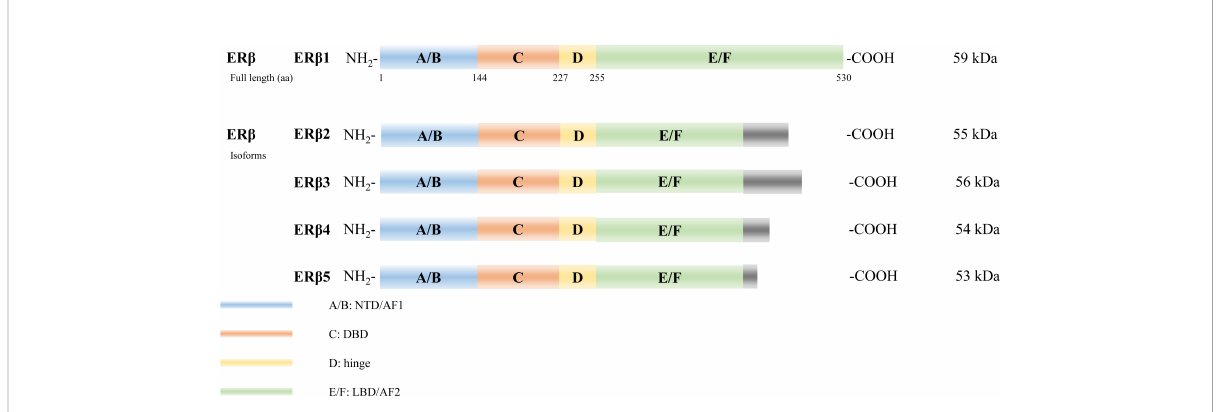
FIGURE 3 Estrogen receptor beta (ER b ) isoforms. Six structural and functional domains are highlighted: A, B domain (amino- or NH 2 -terminal domain [NTD], AF1), C domain (DNA binding domain [DBD]), D domain (hinge region connecting the C and E domain), E, F domain (carboxyl- or COOH-terminal, ligand-binding domain [LBD], AF2).